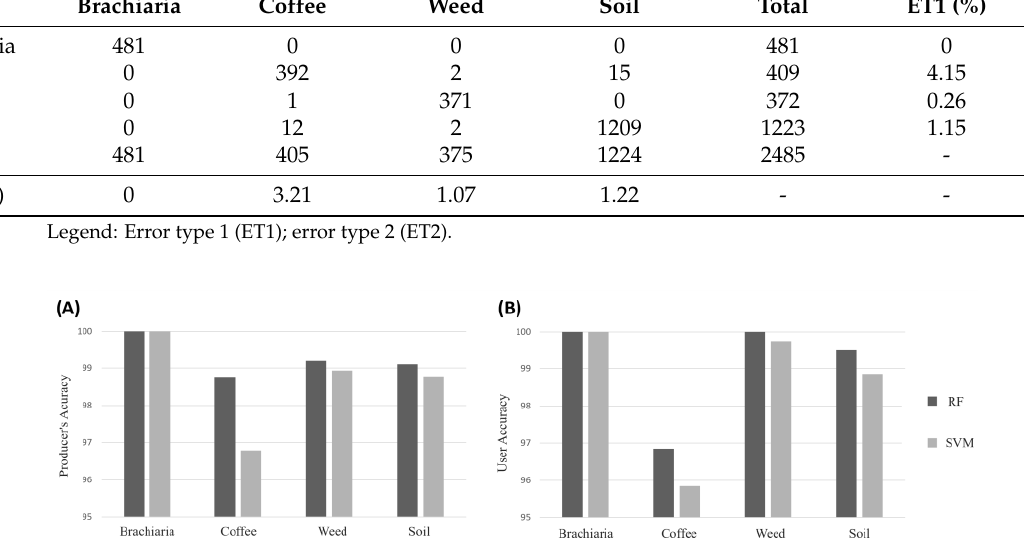
Figure 5. Average producer and user accuracy for each thematic class for ( A ) RF and ( B ) SVM.